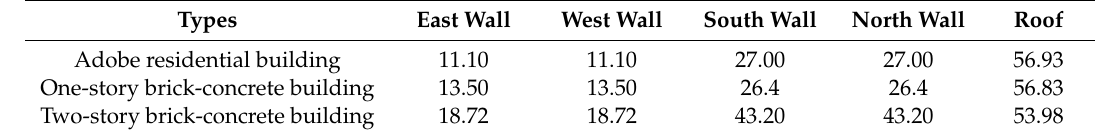
Table 10. Closure structure area A i for three di ff erent residential buildings (m 2 ).